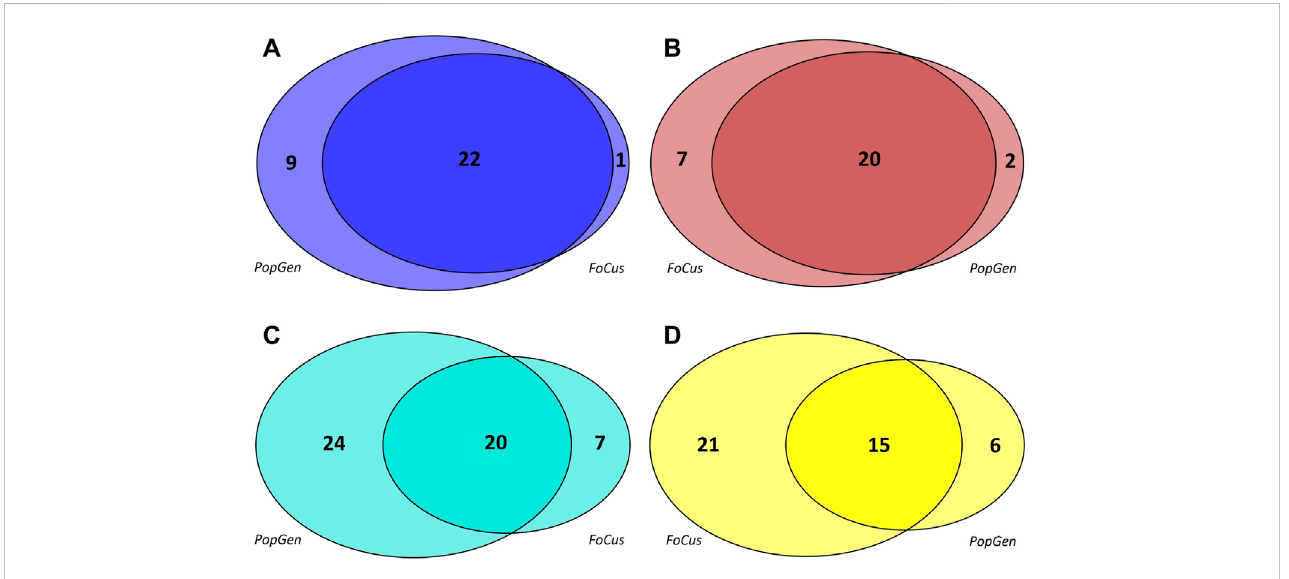
FIGURE 1 Modules detected, by WGCNA, inthe microbial co-occurrence networksof thePopGenand FoCus samples. The size of each circle re fl ects thenumber of constituent genera of the corresponding module; each circle segment contains the number of genera included. For consistency, the original WGCNA coloring was modi fi ed based upon the maximum pairwise overlap between modules. (A) : blue module, (B) : brown module, (C) : turqoise module, (D) : yellow